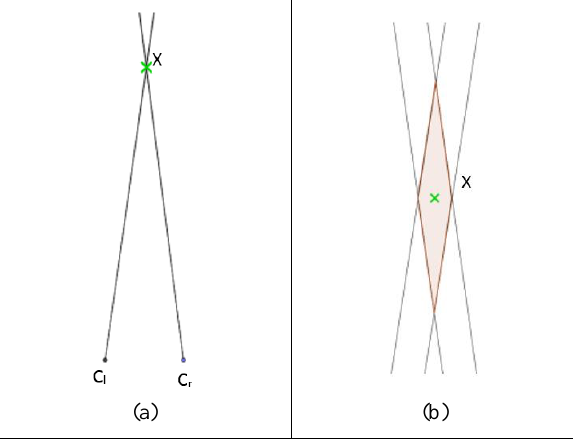
Figure 7. Illustration of wide